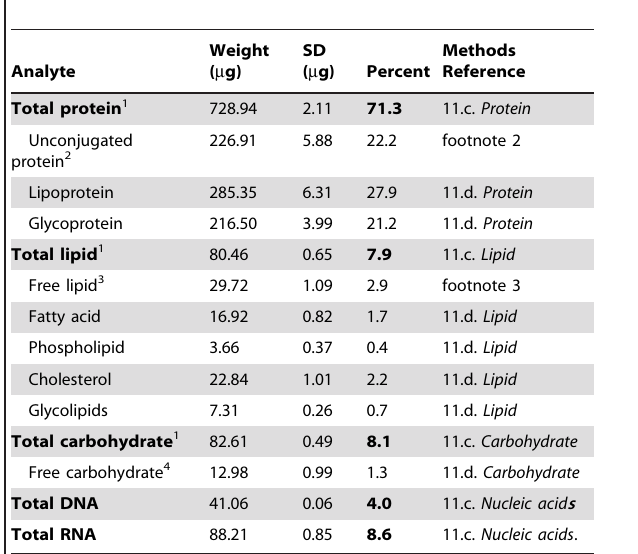
Table 2. Biochemical Analysis of Whole Spiroplasma Cells.